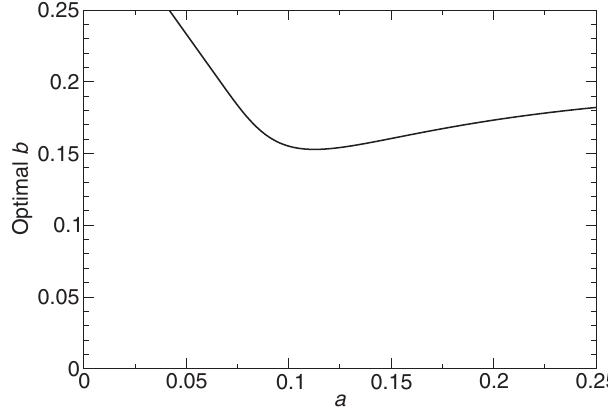
FIG. 16. Value of b which minimizes the fractional loss for the muon FFAG described in the text.